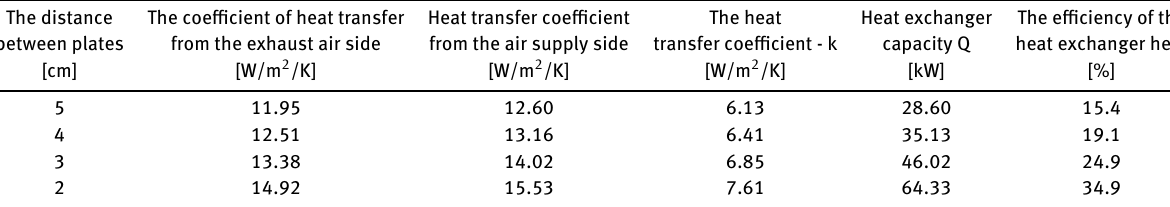
Table 2: The calculation results for the plate heat exchanger. The distance